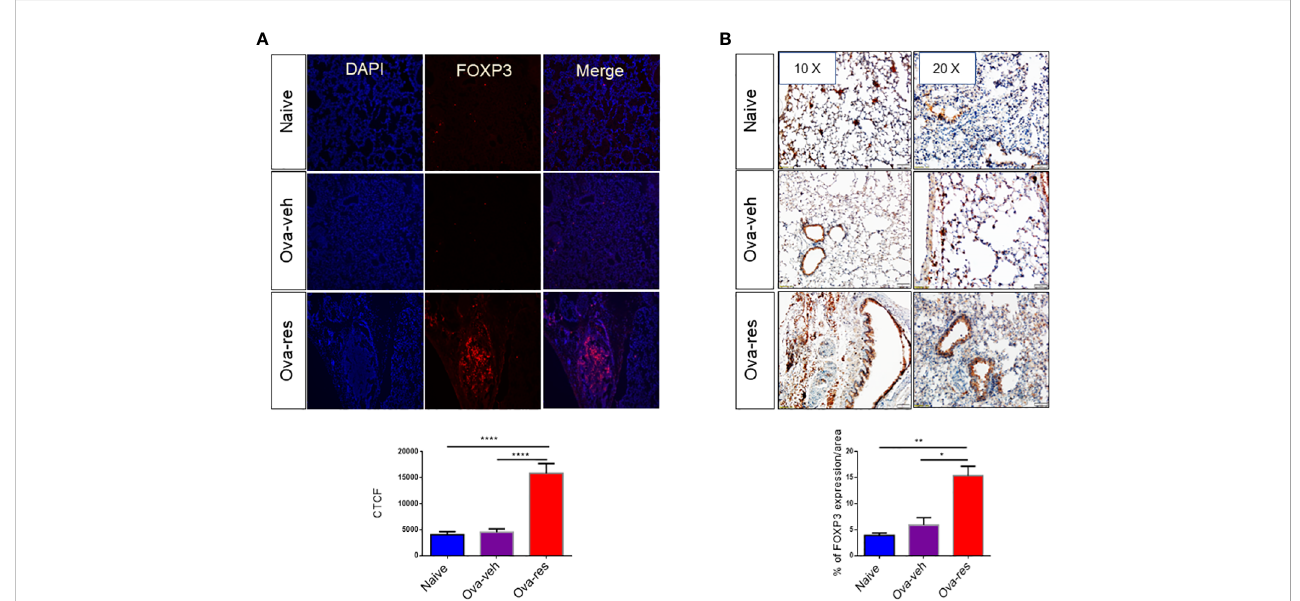
FIGURE 5 Resveratrol treatment leads to induction of FOXP3+ cells in the lungs: Immuno fl uorescence and immunohistochemistry were performed to determine the expression of FOXP3 in lung tissues and FoxP3 expression in the cells was assessed using corrected total cell fl uorescence (CTCF) and ImageJ software. (A) Shows the expression of FOXP3 in lung tissues. The data in vertical bars represent Mean+/ – SEM of 10 random spots analyzed. Signi fi cance (*p < 0.05) of FoxP3 expression between the groups was analyzed using Student ’ s t-test. (B) Shows FoxP3 expression in lung tissues by performing immunohistochemistry. The data represented as Mean+/ – SEM of random 3 – 5 spots that were analyzed. The number of mice used (Naïve: n = 3, OVA- veh: n = 3, and OVA-res: n = 3). Signi fi cance (**p <0.01, ****p <0.0001) in FoxP3 expression was detected using one-way ANOVA and post-hoc Tukey ’ s